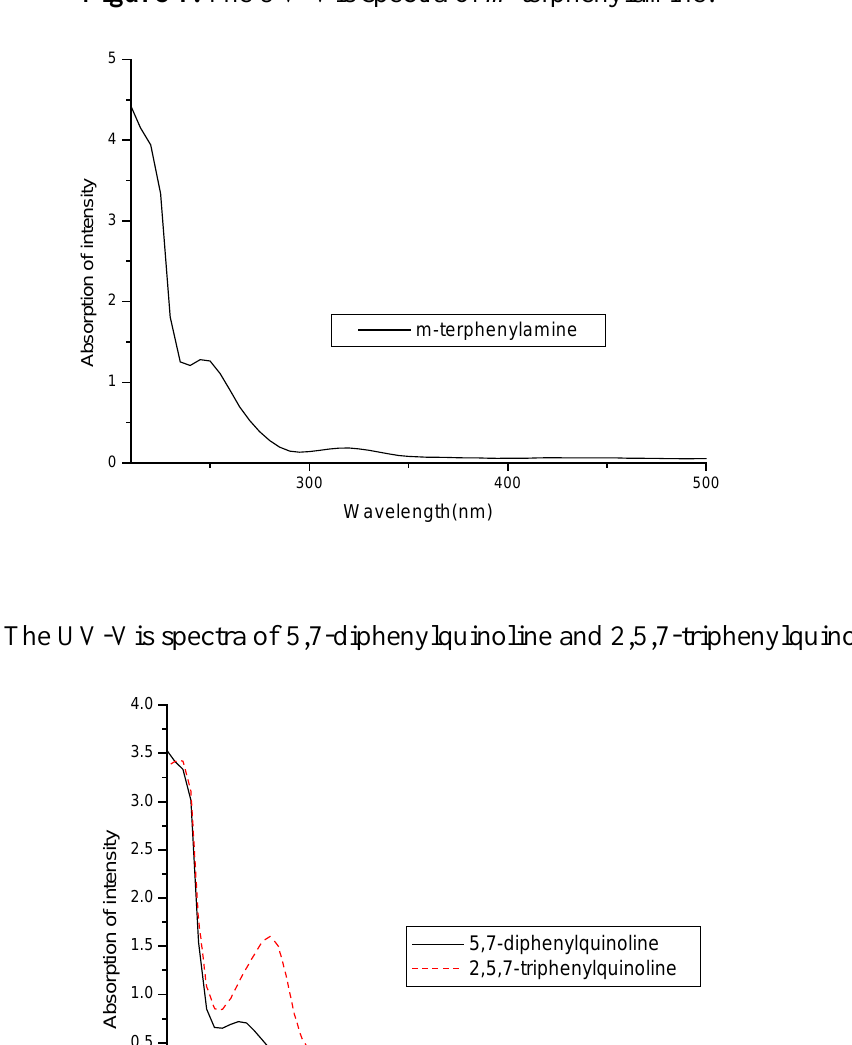
Figure 1. The UV-Vis spectra of m -terphenylamine.